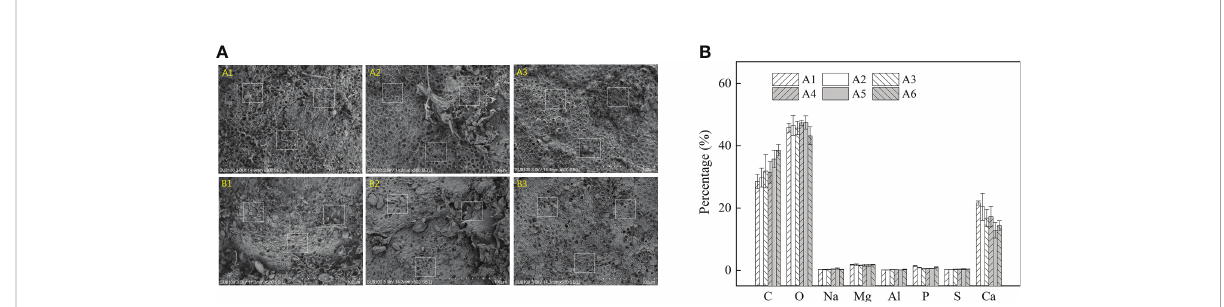
FIGURE 6 The (A) SEM pictures and (B) relative abundance (%) of main elements in the pink sur fi cial crust/pigmented layer across temperature and light treatments for A cf. fragilissima (A1: 60 m mol photons m − 2 s − 1 , 26°C; A2: 80 m mol photons m − 2 s − 1 , 26°C; A3: 120 m mol photons m − 2 s − 1 , 26°C;